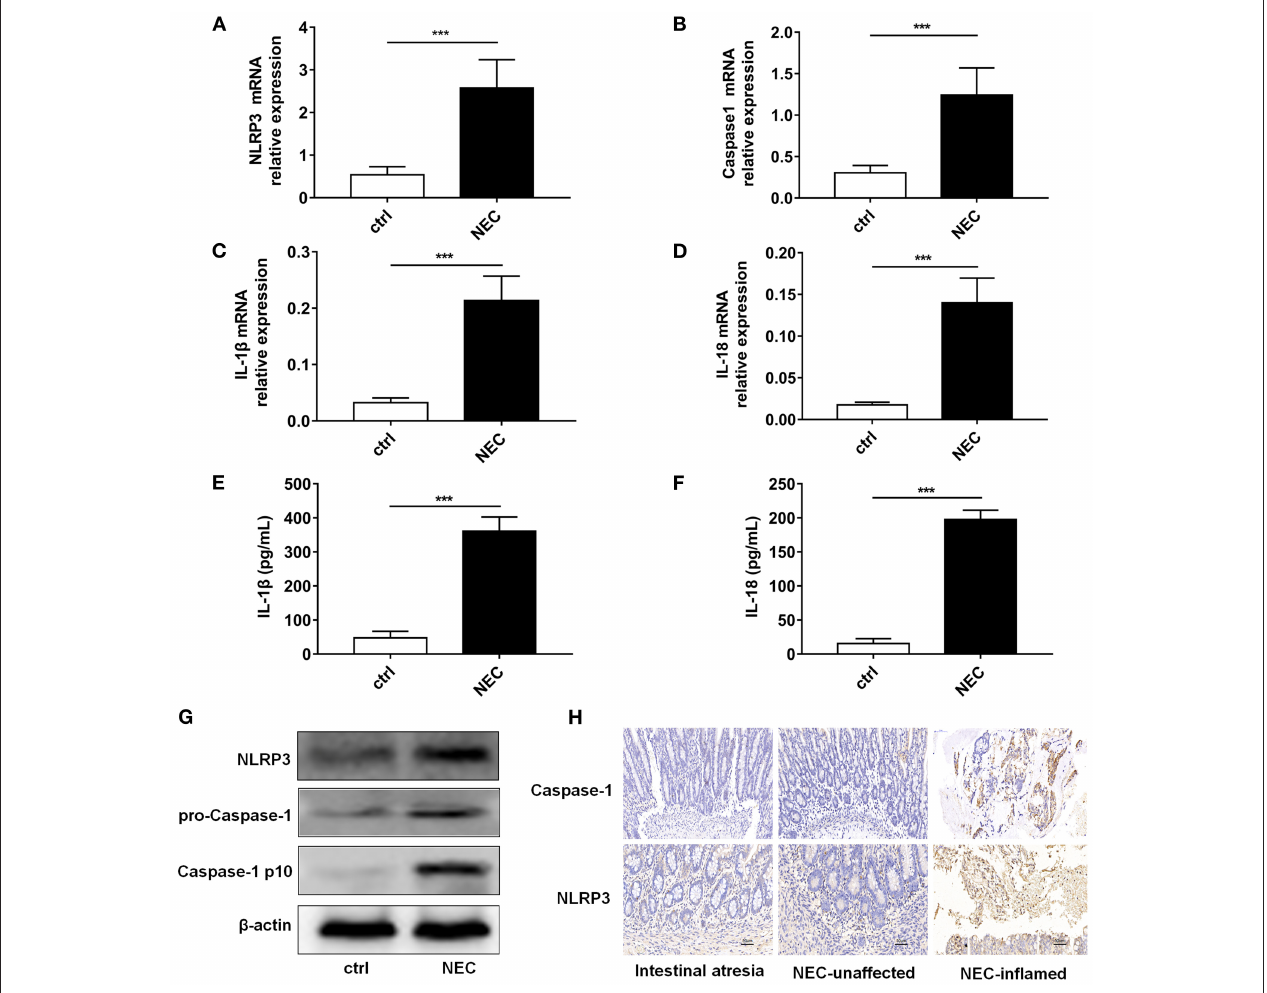
FIGURE 3 | NLRP3 inflammasome activation level in NEC intestinal tissues. The mRNA expression levels of (A) NLRP3, (B) Caspase-1, (C) IL-1 β , and (D) IL-18 level in intestinal tissue of control and NEC mice ( n = 5 per group). ELISA showed the (E) IL-1 β and (F) IL-18 expression levels in intestinal tissue of control and NEC mice ( n = 5 per group). (G) NLRP3, pro-Caspase-1, and Caspase-1 p10 protein expression levels in intestinal tissue of control and NEC mice. β -actin was re-used as the control image. (H) Immunohistochemistry of NLRP3 and Caspase-1 in intestinal tissue of children with intestinal atresia and NEC. Ctrl, control mice; NEC, NEC